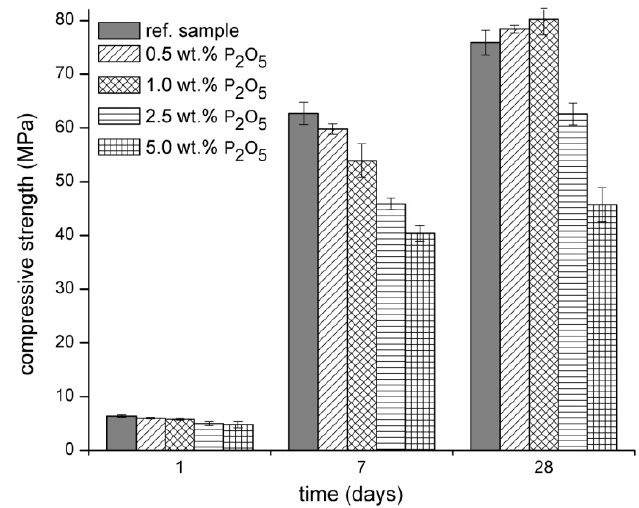
Figure 2. Influence of Na 3 PO 4 on the compressive strength development of alkali-activated BFS.